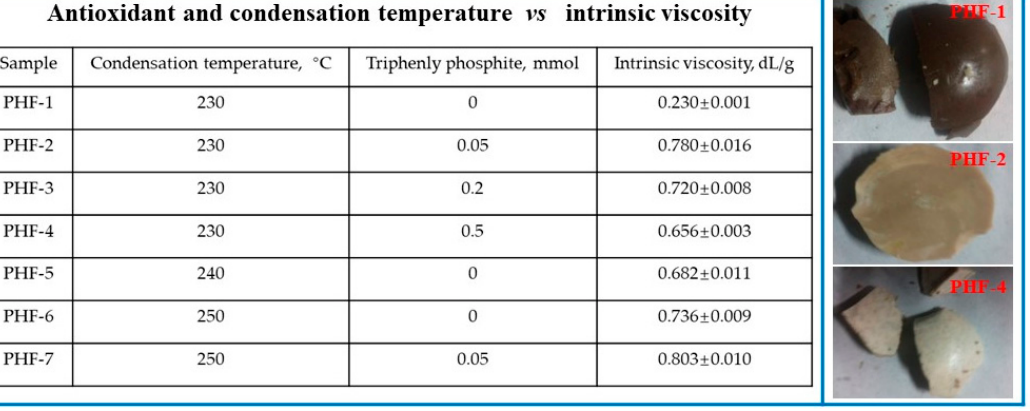
Figure 2. Effect of antioxidant and condensation temperature on the synthesis of PHFs.